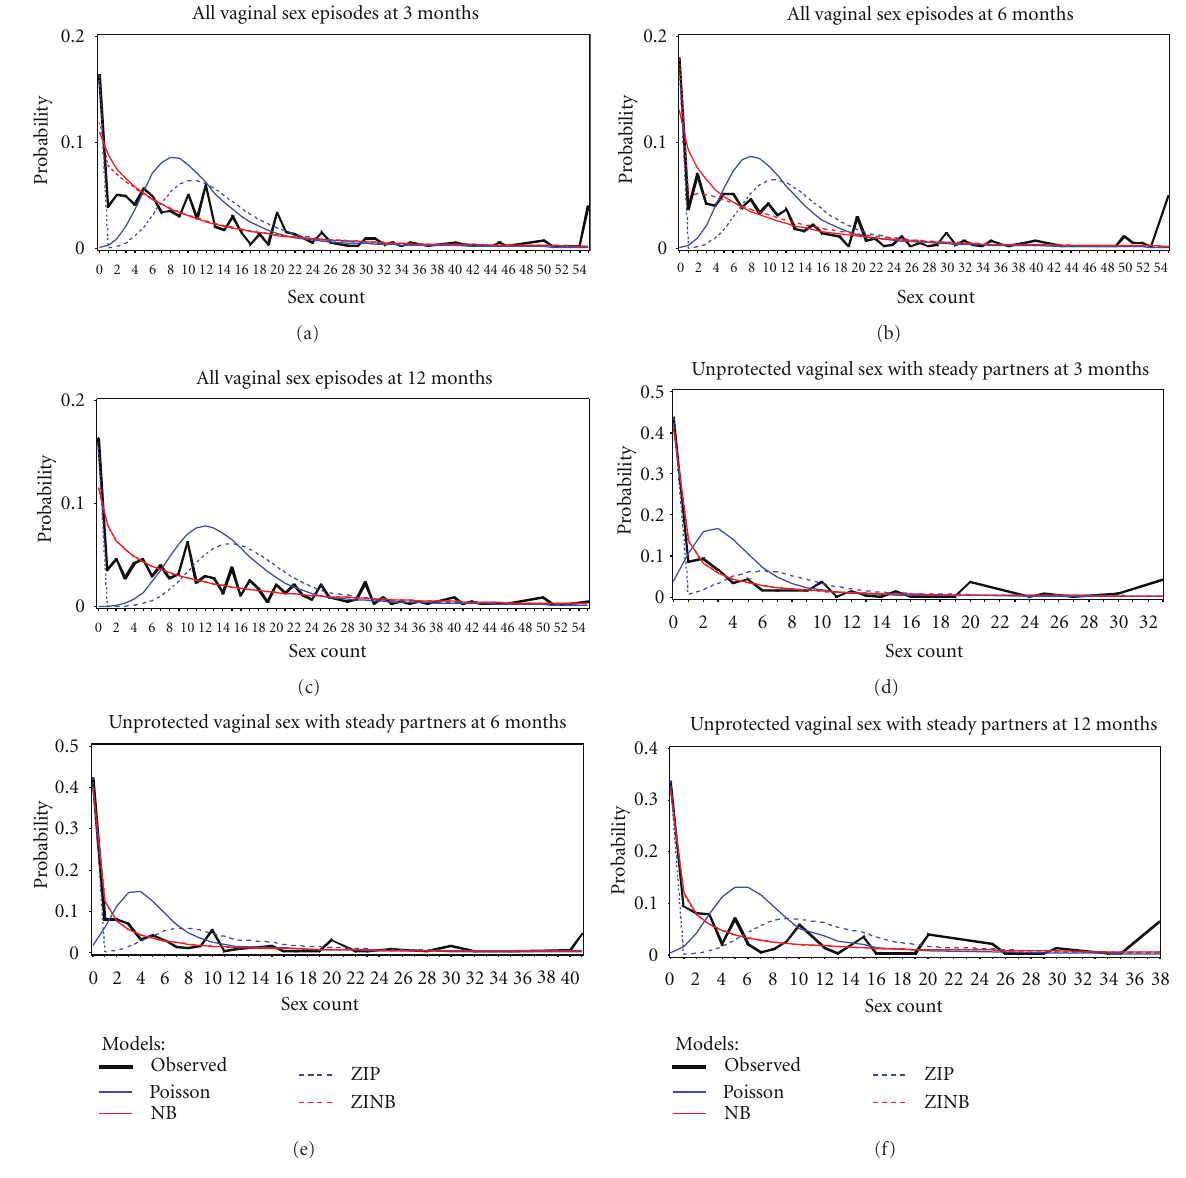
Figure 2: Comparisons between observed and predicted probabilities from four models for all types of vaginal sex episodes and unprotected vaginal sex with steady